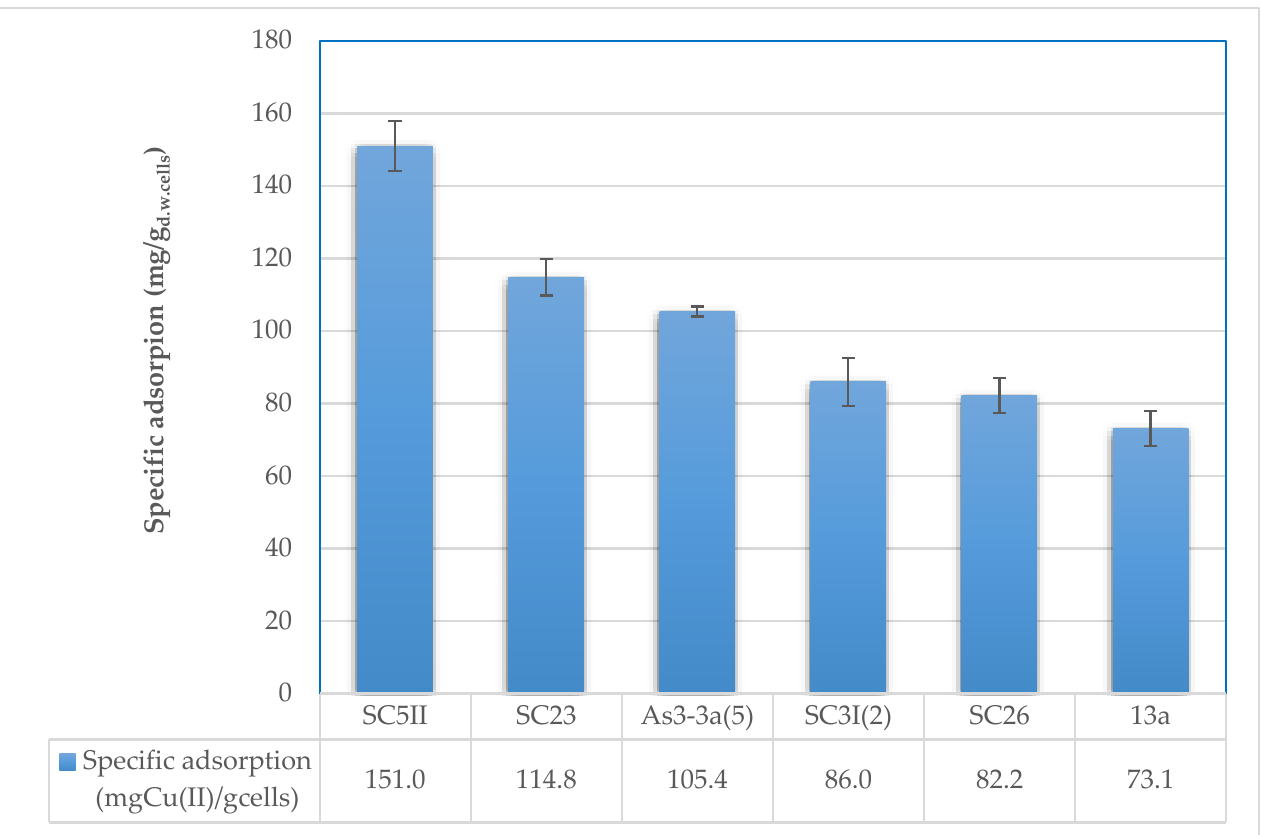
Figure 2. Specific adsorption (mgCu(II)/g d . w . cells ) using vials.